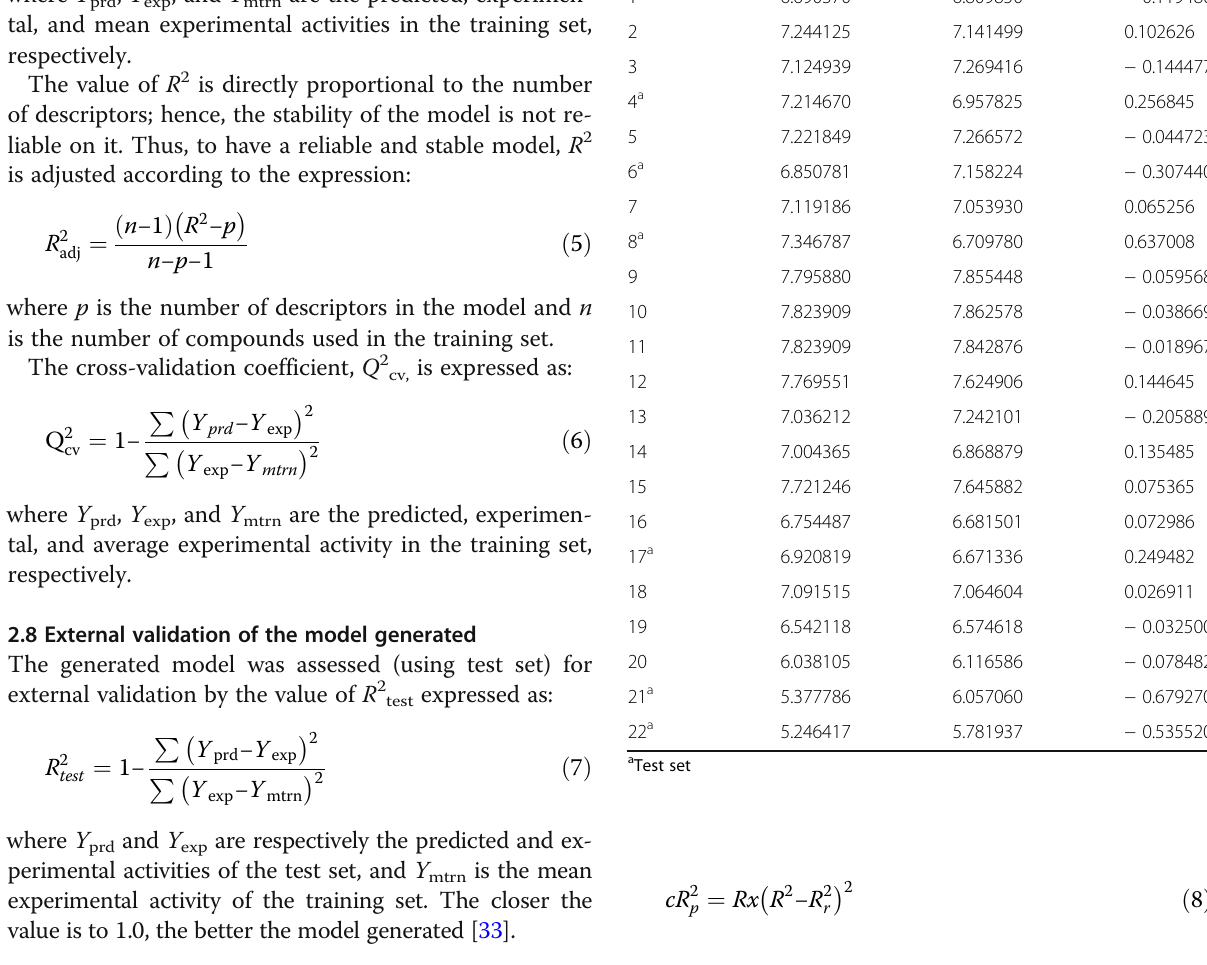
Table 4 Experimental and predicted activities for the compounds with residual Compounds Experimental activity (pEC 50